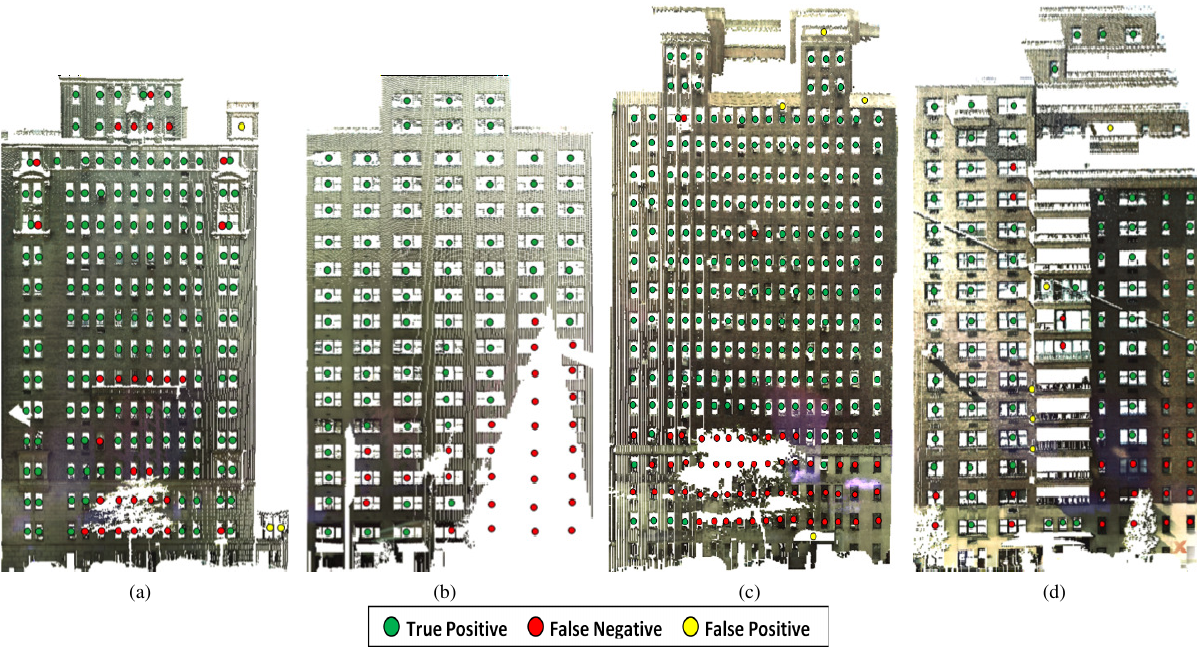
Figure 5: Window detection results are shown for some fac¸ades. In (a), (b) & (c) we can see a number of false negatives due to occlusions. In (c) & (d) we also find some false negatives due to closed windows because of window shutters or curtains.